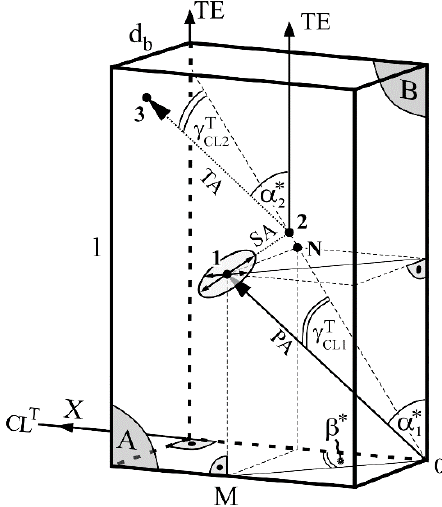
Figure 6. Scheme of primary arm (PA), secondary arm (SA) and tertiary arm (TA) growth in the thin- walled area of airfoil. A and B are the mould wall surfaces. The angles are enlarged for figure